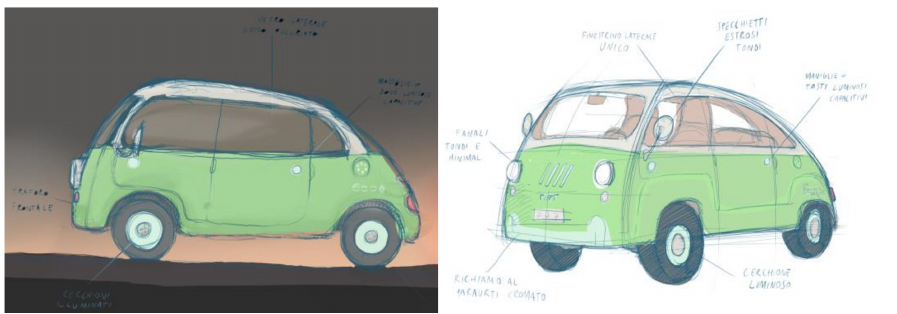
Figure 18. Sketches FIAT 600 Omega: Advanced Design.